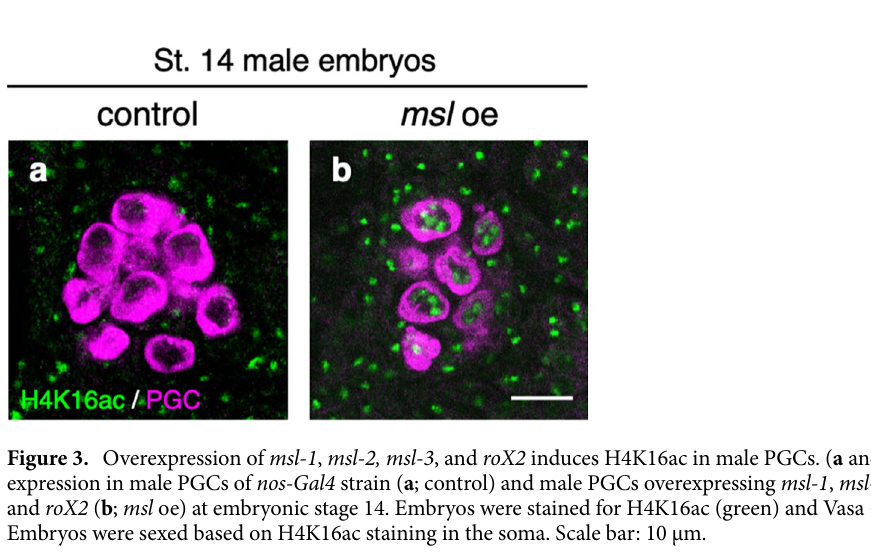
Figure 2. Expression of the transcripts encoding the components of MSL complex in male PGCs during embryogenesis. RNA expression from msl-1 ( a – e ), msl-2 ( f – j ), msl-3 ( k – o ), mof ( p – t ), mle ( u – y ), roX1 ( z – dd ), and roX2 ( ee – ii ) in PGCs at embryonic stage 5 (St. 5; a, f, k, p, u, z, and ee) and in male PGCs at embryonic stages 10–11 (St. 10–11; b, g, l, q, v, aa, and ff), stages 12–13 (St. 12–13; c, h, m, r, w, bb, and gg), stage 14 (St. 14; d, i, n, s, x, cc, and hh), and stage 16 (St. 16; e, j, o, t, y, dd, and ii). Embryos derived from nos-Gal4 / nos- Gal4 females mated with UAS-RFP /Y males were in situ hybridized with a probe for each gene (green) and immunostained for Vasa (magenta) and RFP. Because nos-Gal4 activates UAS-RFP only in female PGCs from stage 9 onward, the sexes of PGCs could be determined by RFP signal at stages 10–16. Probes were designed to detect all RNA variants identified in each gene region. Scale bar: 10 µm. White arrowheads show PGCs with high-level signals (green).